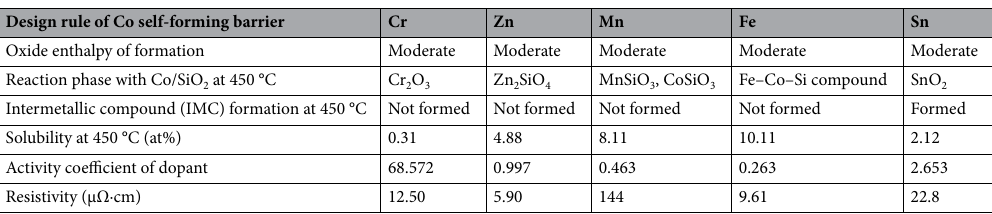
Table 1. Comparison of Co alloy elements for self-forming diffusion barrier (SFB): six design rules were used to determine which of the five dopants is suitable as a self-forming barrier material. The activity coefficient and solubility of the dopant are thermodynamically calculated values. The resistivity of each metal represents the bulk value of the resistivity.